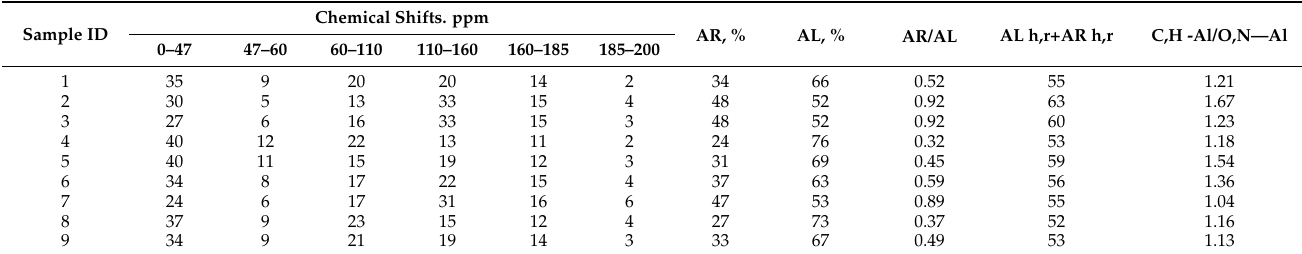
Table 4. The molecular composition of HAs isolated from studied soils. Sample IDs correspond to Table 1. AL h,r+AR h,r —hydrophobicity degree; C,H-Al/O,N-Al—the degree of decomposition of organic matter. Sample ID